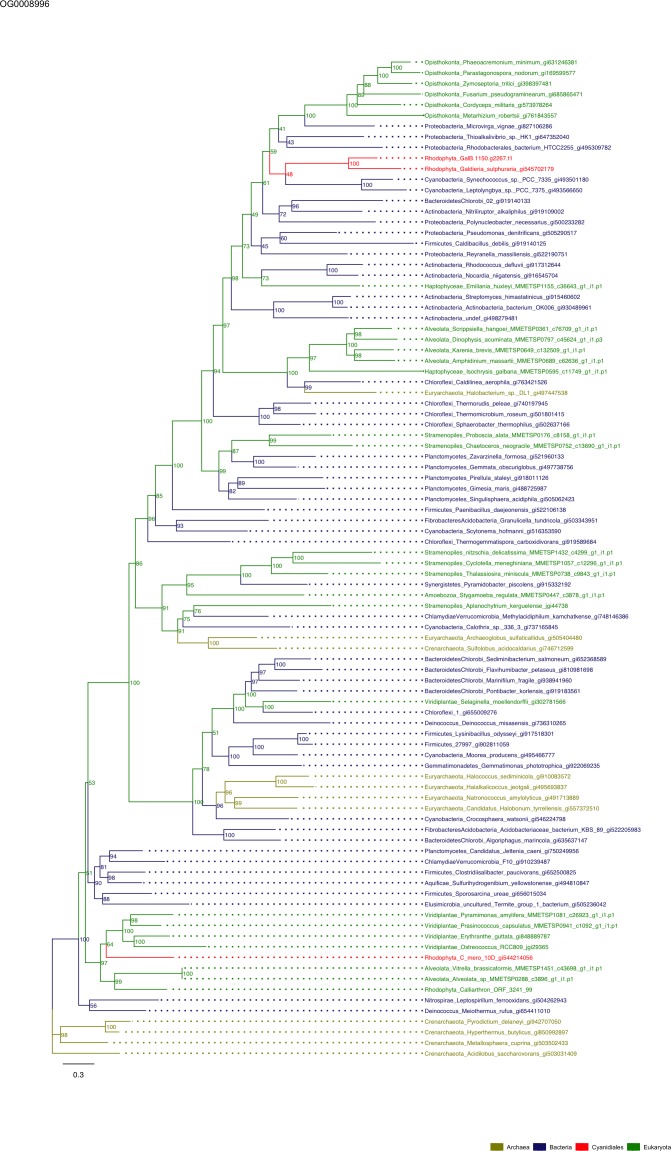
Sequence tree of orthogroup OG0008996.The tree is based on amino acid sequences. Archaea (yellow), Bacteria (blue), Cyanidiales (red), Eukaryotes including other red algae (green). Branches containing Cyanidiales sequences are highlited in red.